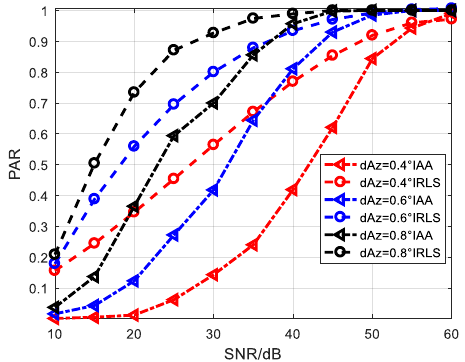
Figure 6. PAR (double target without interference).